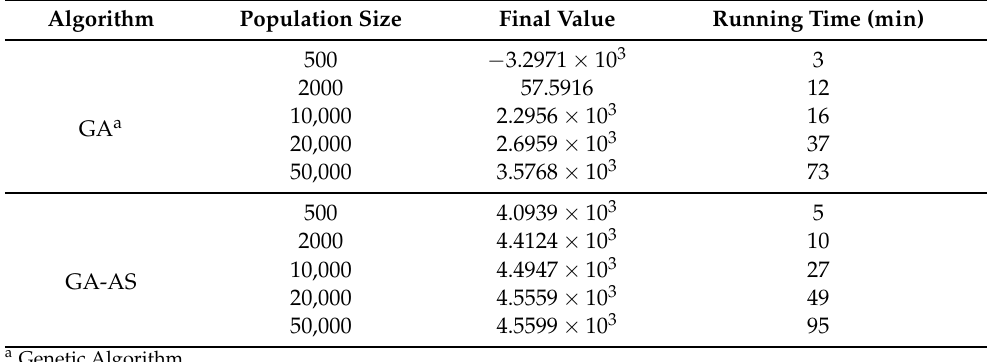
Table 3. Optimization results with different population sizes.